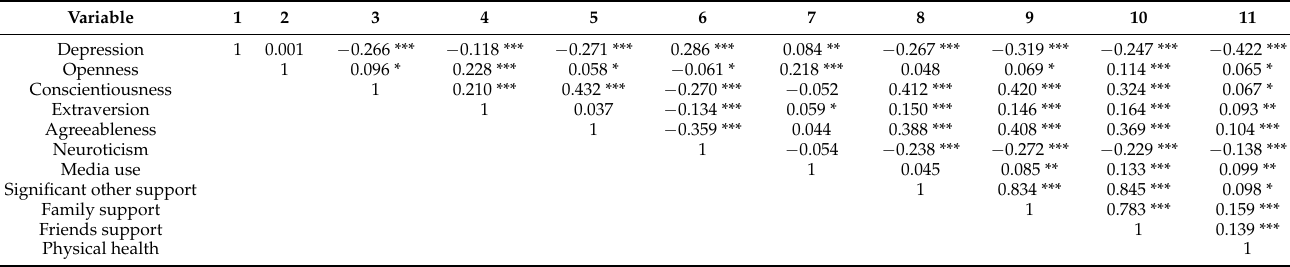
Table 2. Correlation analysis between the scores of PHQ-9 and the other